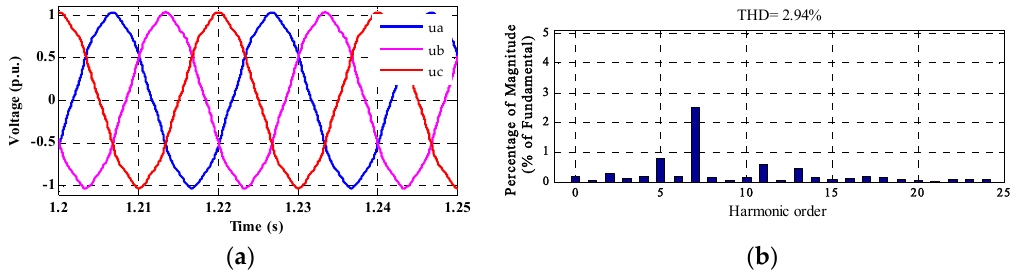
Figure 13. Simulation results of 7th harmonic testing. ( a ) 3-phase voltage waveform; ( b ) voltage spectrum.